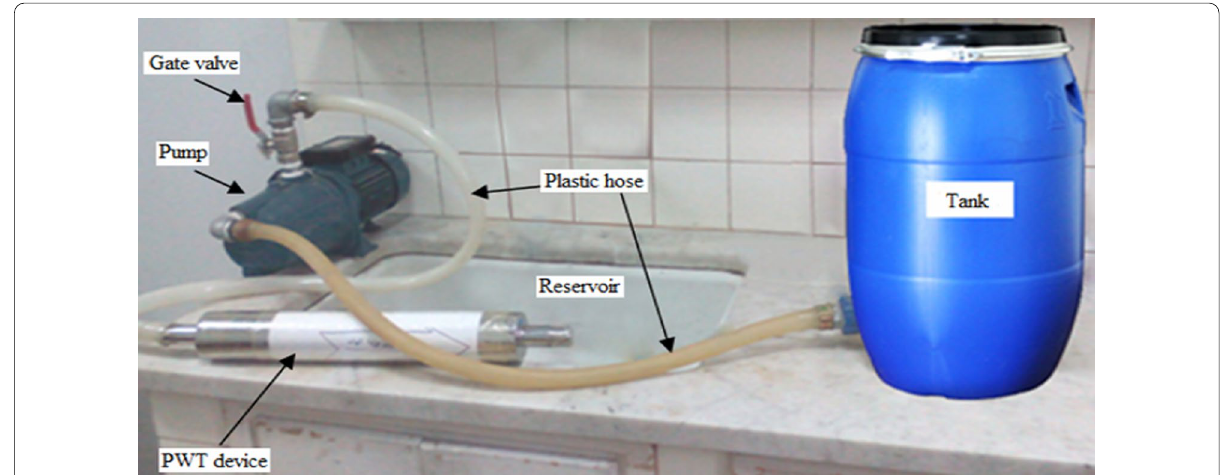
Fig. 5 Water treatment system in case of using open loop